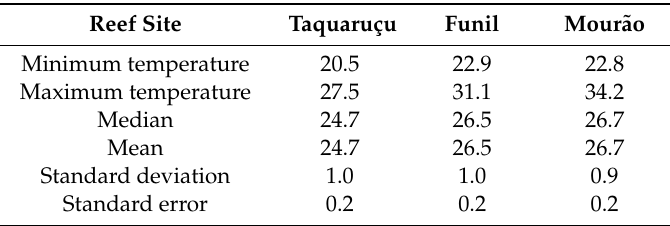
Table 1. Seawater surface temperature ( ◦ C) during the 6 month (from January 2015 to June 2016) monitoring period in the three sites of the Recife de Fora Marine Protected Area (Southwestern Atlantic) during the El Niño Southern Oscillation. Reef Site